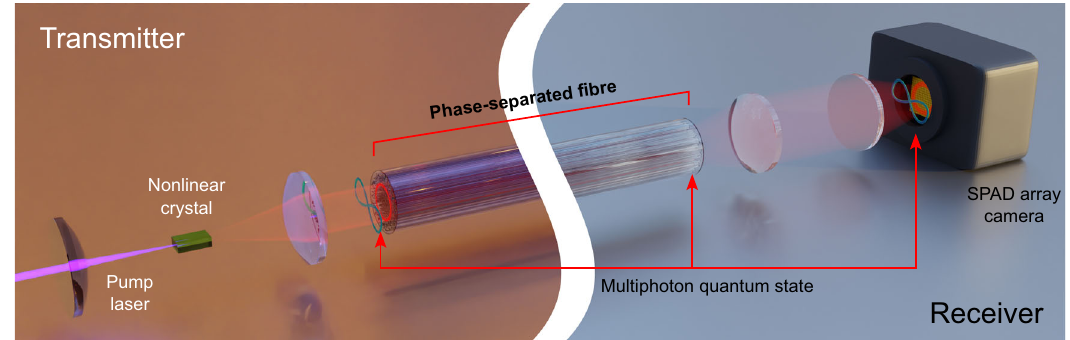
Fig. 1 Schematic overview of the experiment. We are able to transport and retrieve multiphoton states with quantum correlations with a phase-separated Anderson localization fi ber; for that, we do not require a speci fi c match between the ring-shape quantum light beam and the localized modes supported by the phase-separated Anderson localization fi ber. We achieve this by performing photon coincidence imaging with a single photon avalanche diode (SPAD) array camera. This result suggests that phase-separated Anderson localization fi ber could enable applications in quantum imaging or quantum